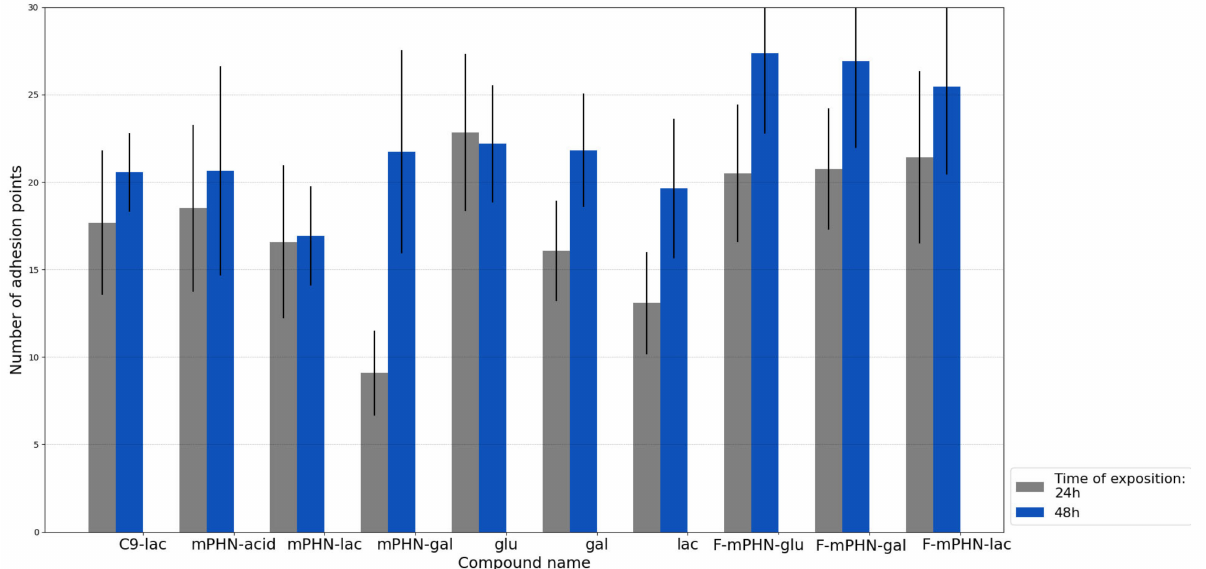
Figure 4. Number of adhesion points formed by DU145 cells during incubation with the investigated compounds (with concentrations below IC 50 ). Adhesion points defined as dot forms placed in the focal plane located between the cell body and glass surface. Their greater number may suggest intensification of migration process caused by investigated compounds. In case of HTB140 cells, no vimentin analysis was performed due to its almost complete depolymerization which indicates strong impact of SFAE on